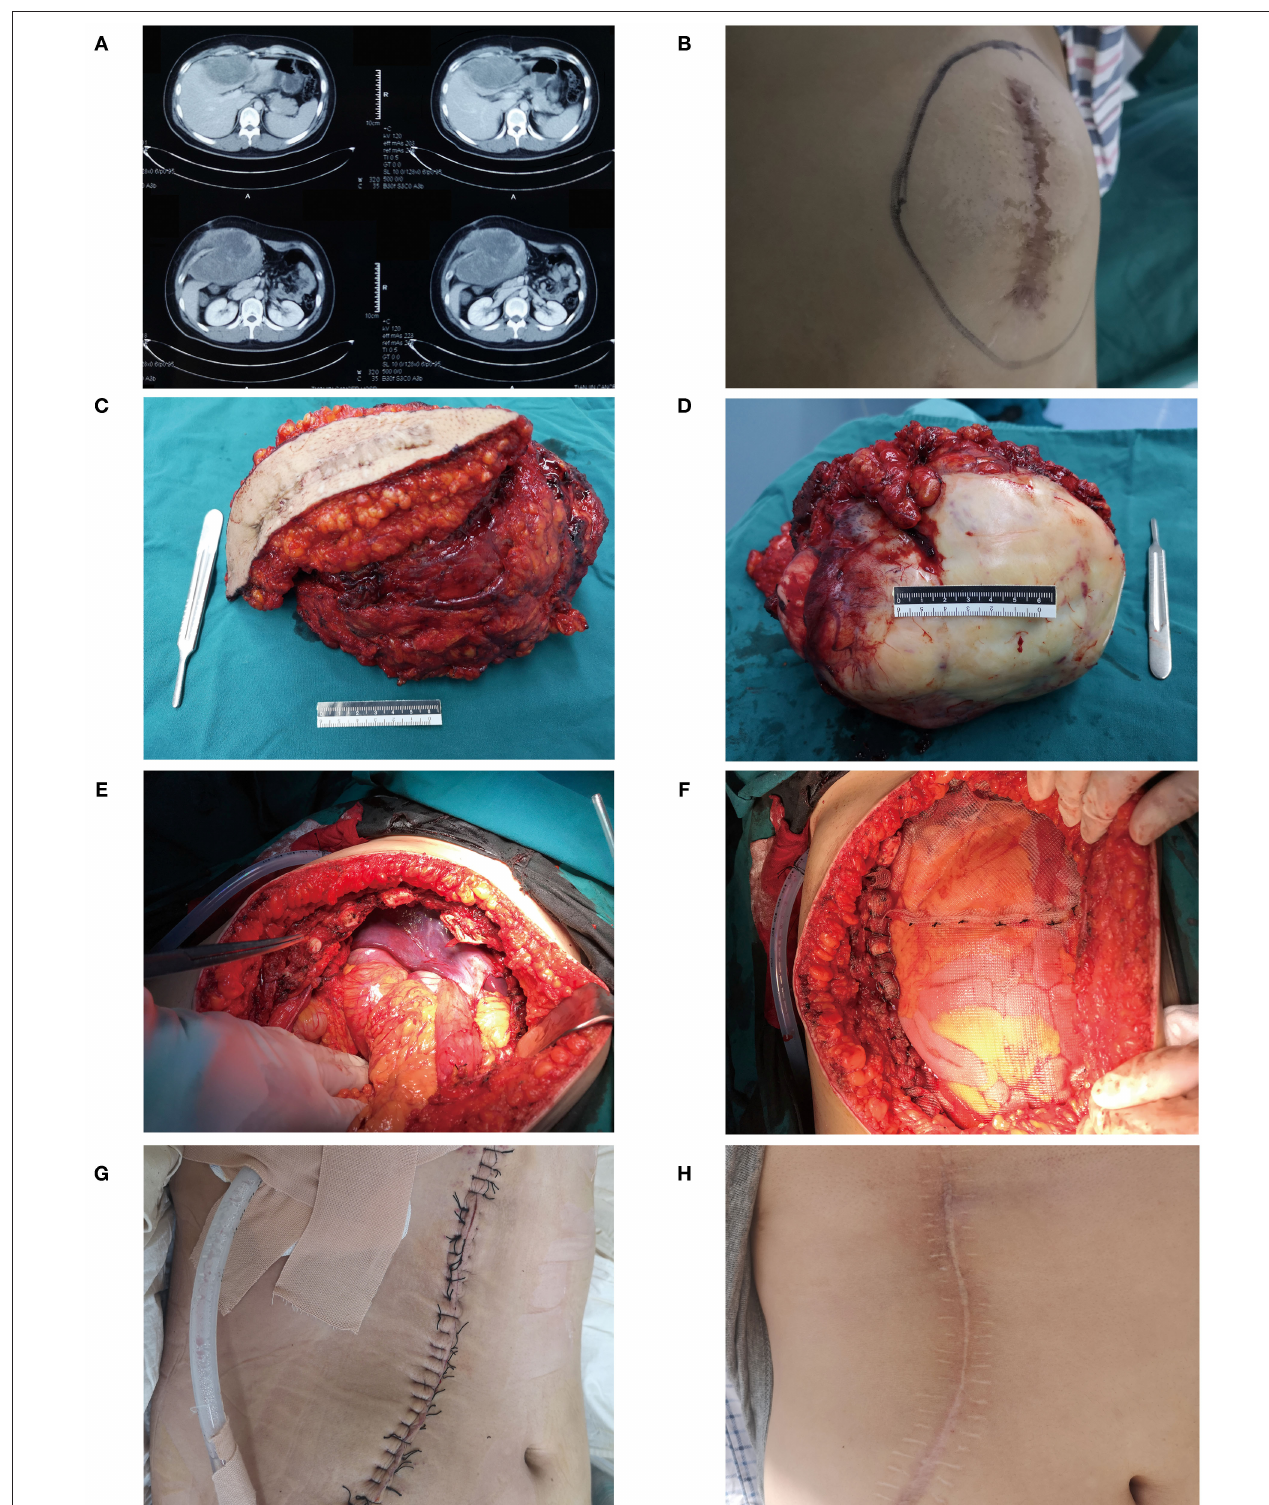
FIGURE 3 | A typical case of DT in a 20-year-old male. (A) Preoperative CT scan showed a large mass in the right anterior abdominal wall, and the liver had low-density areas due to tumor compression. (B) A huge mass can be seen at the right chest wall. (C) The previous surgical scar was removed with the tumor. (D) A gross specimen of the tumor. (E) The patient underwent aggressive surgery, and the invaded diaphragm and ribs were removed. (F,G) We reconstructed the junction of the right chest wall and abdominal wall with a biological patch. (H) During the follow-up, the patient recovered well.